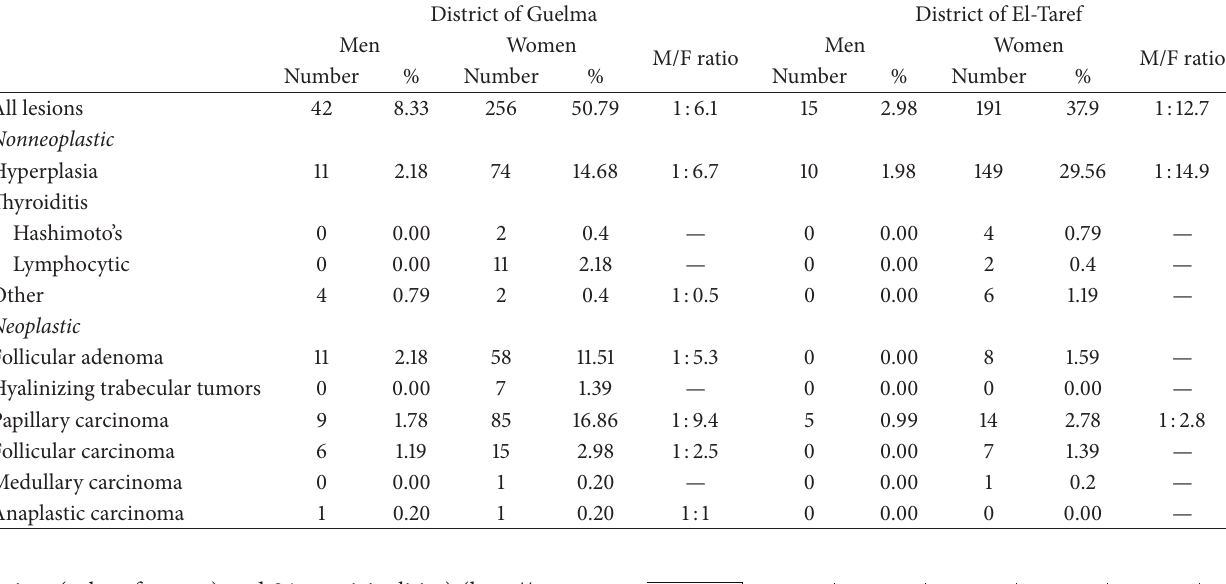
Table 1: Histopathological definition of cases.